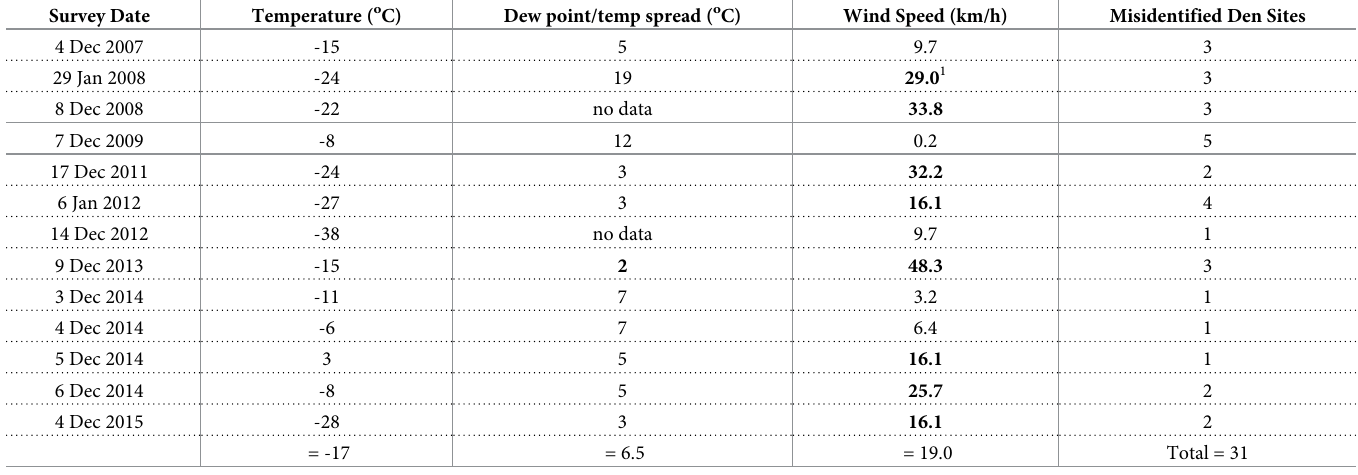
explanation for the failure of industry AFS to detect dens. However, Amstrup and Gardner [1] reported November 11 as the mean den entrance date for polar bears denning successfully on land. Rode et al. [19] also reported a November 11 mean den entrance date (SD of 18.5 d) for polar bears in northern Alaska. While it is possible for bears to have entered dens after survey dates presented in Table 2, nearly 95% of all bears were denned before 4 December (USGS 2018)—the earliest recorded industry AFS effort. Hence ambient conditions and other limita- tions of FLIR are more likely drivers of the low detection rate of industry AFS. Table 2. Prevailing weather conditions during FLIR aerial survey flights for polar bear den detection, northern Alaska, 2007–2016. We were not provided weather data for surveys conducted prior to